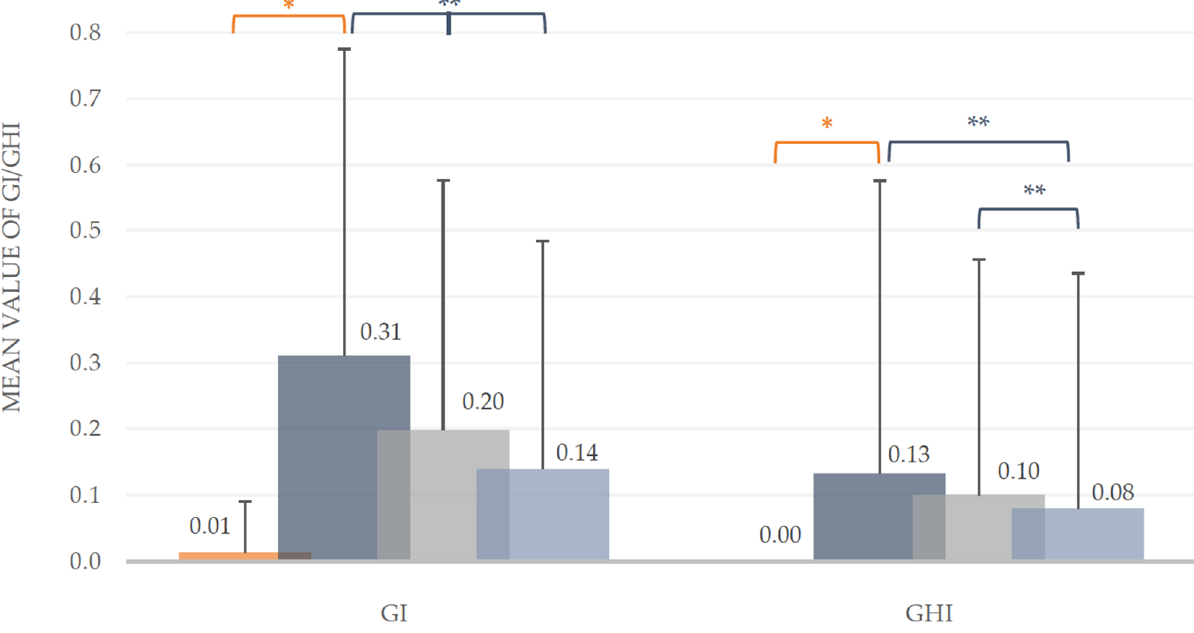
Figure 3. Silness/Loe Gingival Index (GI) and Gingival Hyperplasia Index (GHI). Mean values including standard deviation of the intervention group (CHD) and healthy control group (HCG) at baseline and during the two follow-ups (FU1 and FU2) of the CHD group. * Mann-Whitney-U test ( p < 0.05), ** Wilcoxon test ( p <